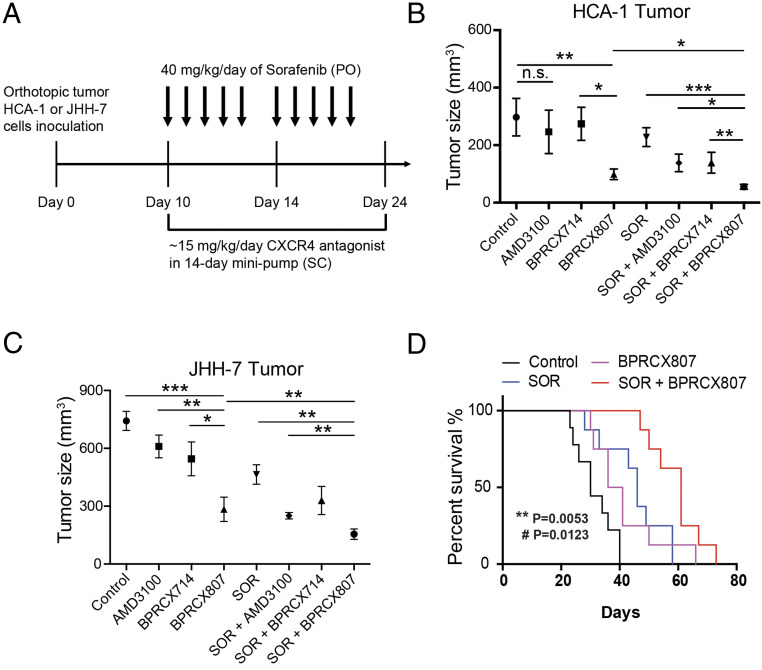
BPRCX807 sensitizes HCC to sorafenib treatment in orthotopic HCC models. (A) Experimental design. Ten days after implantation of HCA-1 cells, mice were treated with BPRCX807 using minipumps (15 mg⋅kg−1⋅d−1, SC) and with sorafenib (40 mg⋅kg−1⋅d−1, oral) five times per week, and tumor size was measured on day 24. (B) Tumor volumes of orthotopic HCA-1 (n = 10 mice for control and BPRCX807; n = 6 mice for AMD3100, BPRCX714 and SOR + BPRCX714; n = 13 mice for SOR, SOR + AMD3100 and SOR + BPRCX807) or (C) JHH-7 (n = 34 mice for control; n = 10 mice for AMD3100, SOR + BPRCX807 and SOR + BPRCX714; n = 5 mice for BPRCX714; n = 7 mice for BPRCX807; n = 24 mice for SOR; n = 21 mice for SOR + AMD3100) in response to treatment with individual CXCR4 antagonists or in combination with sorafenib. The data are the mean value ± SEM. *P < 0.05, **P < 0.01, and ***P < 0.001; n.s., not significant. (D) The overall survival (n = 8) in the orthotopic HCA-1 model. **P = 0.0053, SOR plus BPRCX807 vs. SOR alone; #P = 0.0123, SOR plus BPRCX807 vs. BPRCX807 alone.